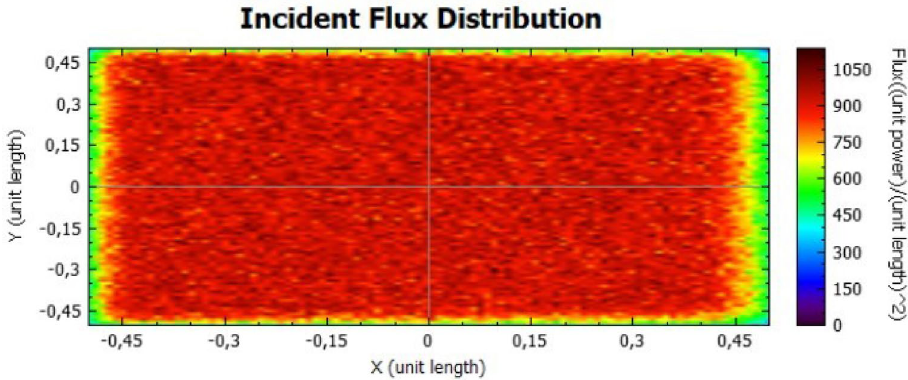
Figure 14. Incident Flux Distribution for an optical error of 0.010 (Flat Concentrator; 92% of reflectivity).